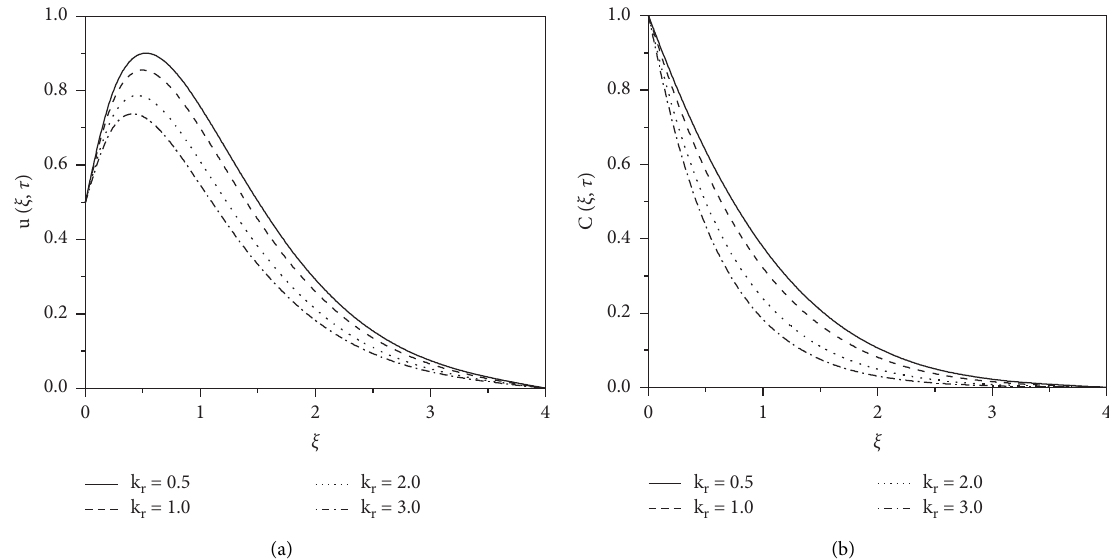
Figure 8: Variation of (a) velocity u ( ξ , τ ) and (b) concentration C ( ξ , τ ) against ξ for various values of k 0.00.20.40.60.81.0 τ ) , ( ξ u